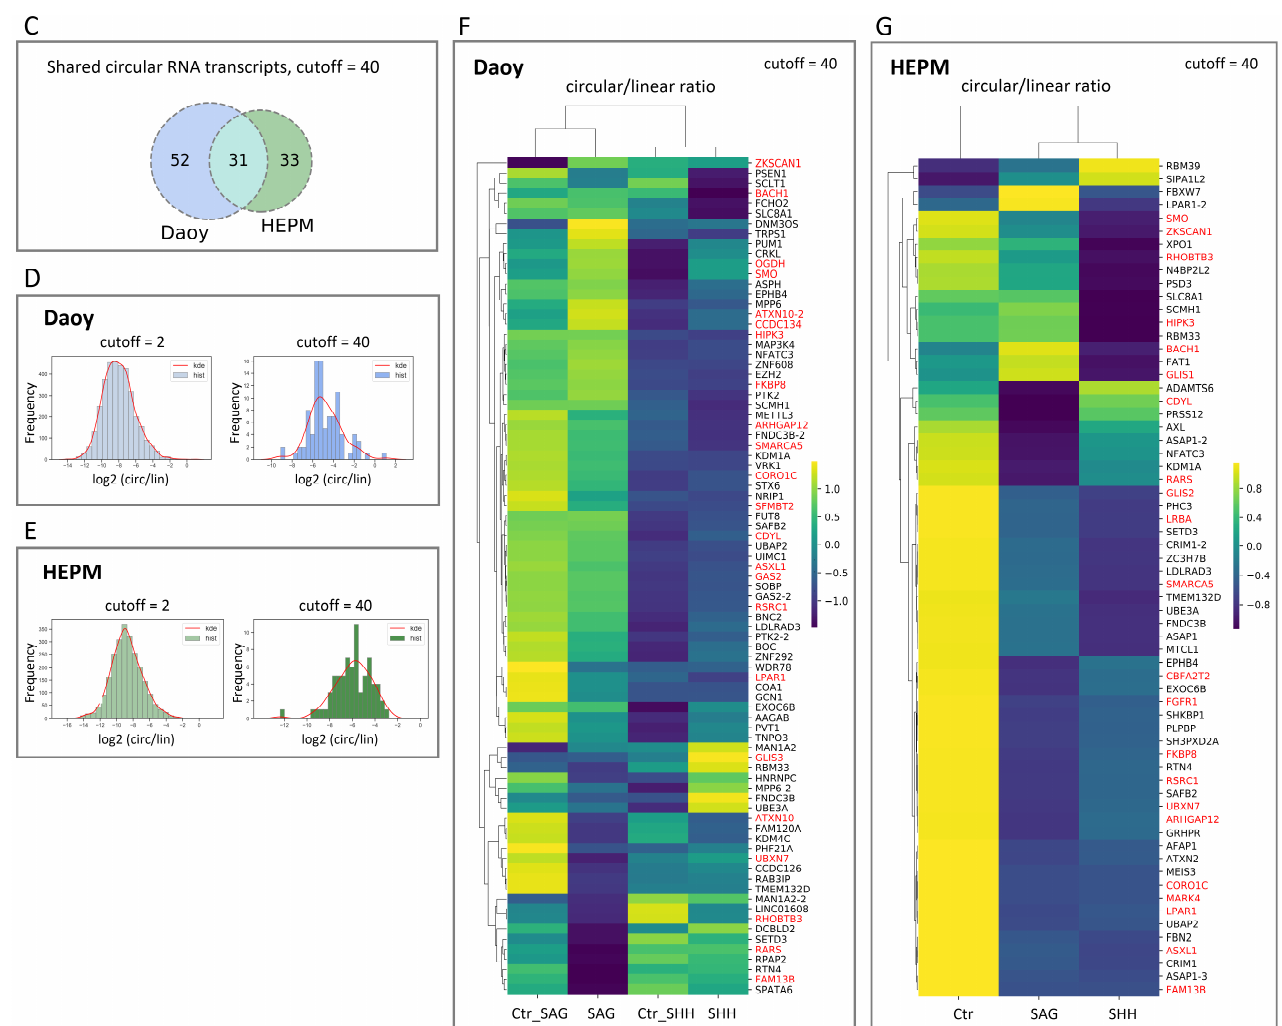
Figure 2. circRNA expression is not correlated with the respective linear mRNA expression. ( A ) Daoy and ( B ) HEPM cell Illumina RNA-seq DESeq2 normalized mean circular counts (as log 2 (circular counts + 1) on the x axis) are plotted against their respective mean linear counts (as log 2 (linear counts + 1) on the y axis) together with the regression fits between the circular and linear counts. Marginal plots at the top and at the right represent histogram and kernel density plots for the circular and respective linear counts. The low Spearman rank correlation coefficients indicate a poor relationship between the circular and linear RNA-seq reads from the same gene. The mean circular read cutoffs were implemented to differentiate the low (cutoff = 2) and the highly (cutoff = 40) expressed circRNAs. Selected genes (Table 1) are annotated in the plots. Note the relatively small fraction of genes that pass the mean circular read cutoff = 40. ( C ) Venn diagram representing the overlap of circRNAs expression in Daoy and HEPM cells at cutoff = 40. ( D,E ) Histogram and kernel density (kde) plots (hist) of the log 2 (circular/linear) ratios for the RNA circles at low (cutoff = 2) and high (cutoff = 40) read thresholds in Daoy (D) and HEPM ( E ) cells. ( F,G ) Heatmaps with hierarchical clustering based on circular/linear ratios of DESeq2 reads at cutoff = 40, by treatment group (Control, SAG, or SHH) in Daoy ( F ) and HEPM ( G ) cells. Shown in each row are the normalized z-scores (see Materials and Methods) for each gene. Yellow indicates higher circular/linear ratios, while blue lower. Selected genes (Table 1) are highlighted in red.